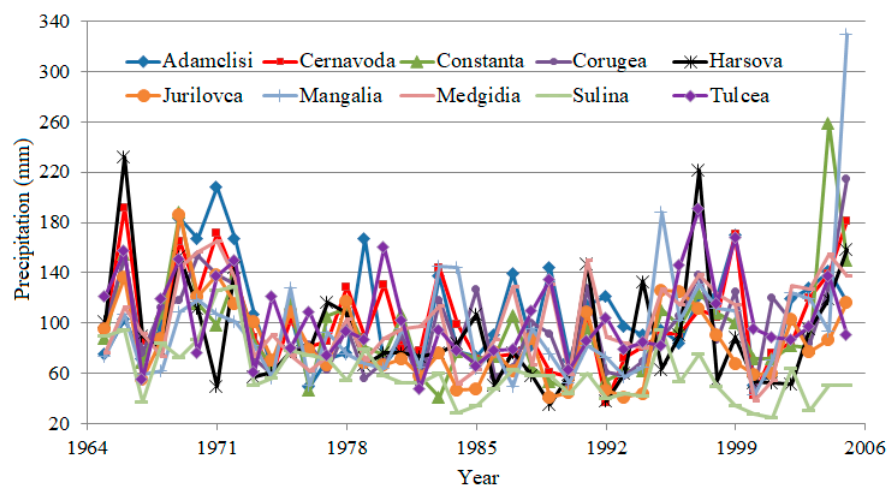
Figure 1. The map of the Dobrogea region and the stations where the data series were recorded.